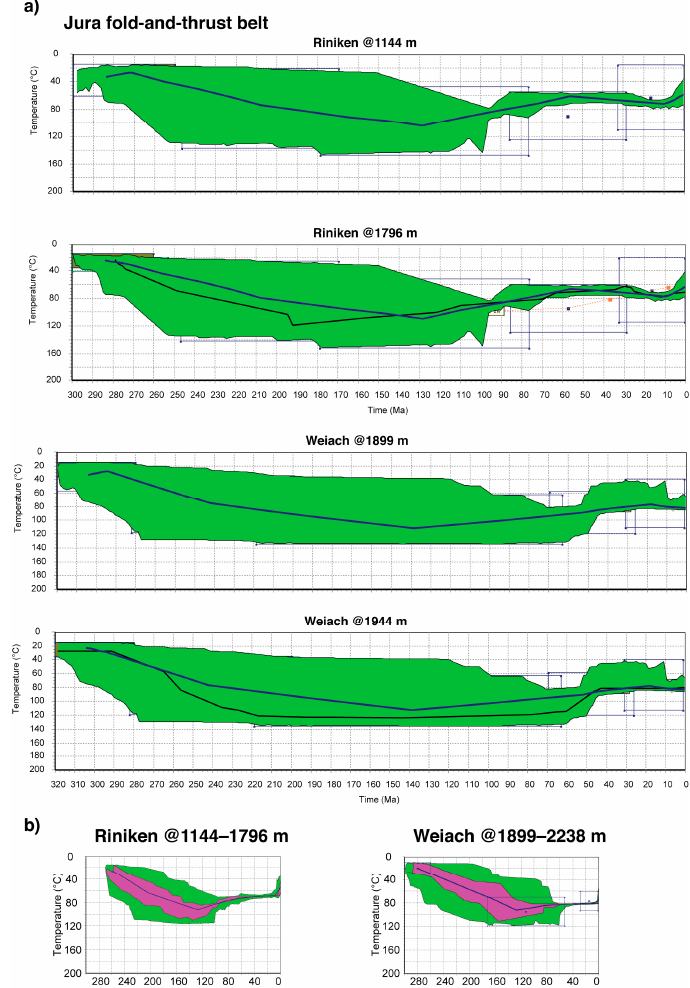
Figure 6. ( a ) Simultaneous thermal histories for Weiach and Riniken wells following the approach of [60]. ( b ) Thermal models that integrate samples from the same boreholes (Weiach and Riniken) that do not have a missing section between them. The best-fitting and the weighted mean paths are shown as solid dark blue and black lines, respectively. The good-fit envelope of solutions (all solutions with a goodness of fit of 0.5 and higher) are shown in pink. Green areas are histories with acceptable fits (goodness of fit between 0.05 and 0.5).